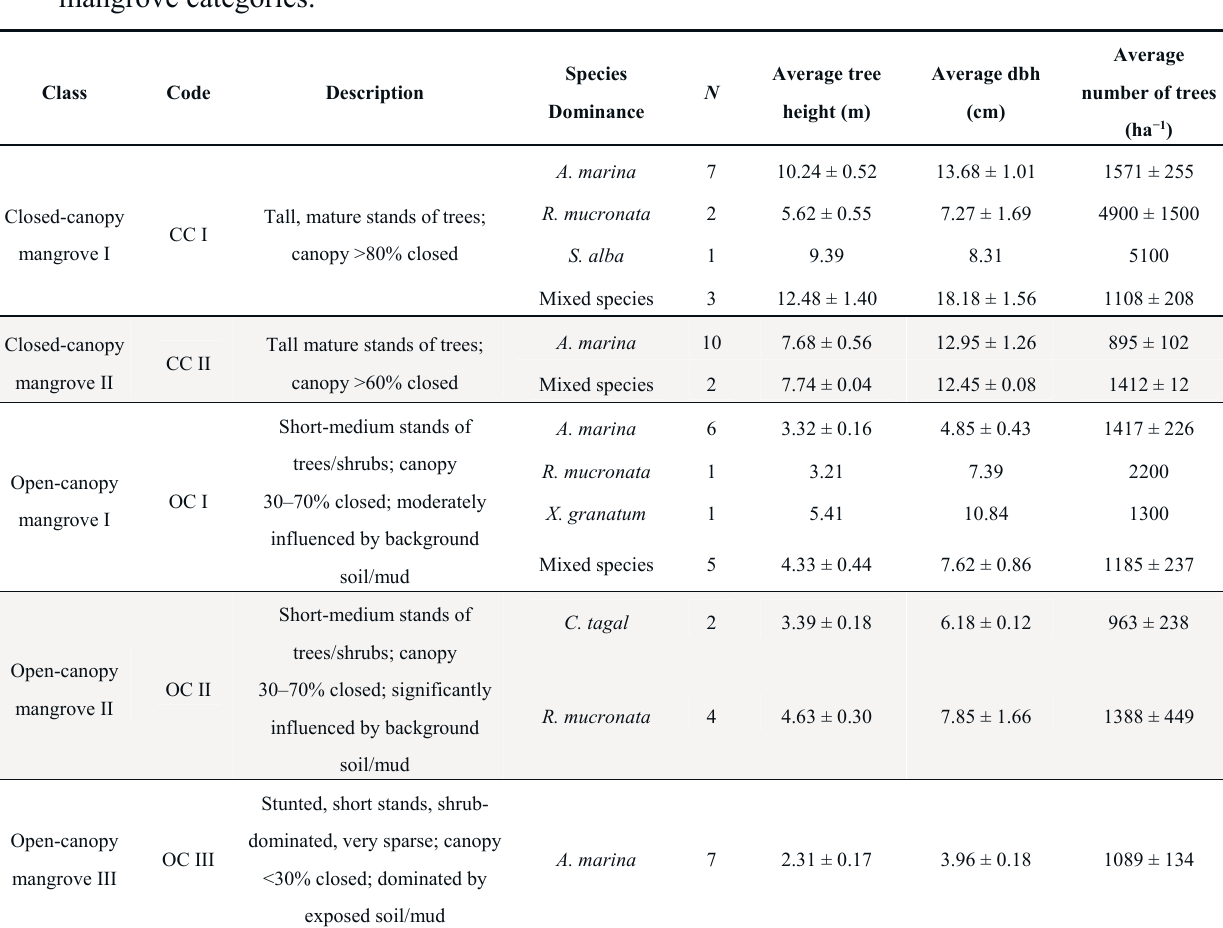
Table 4. Mangrove class, species dominance, average tree height ± standard error (SE) (m), average dbh ± SE (cm), and average trees per hectare ± SE (ha) for mapped mangrove